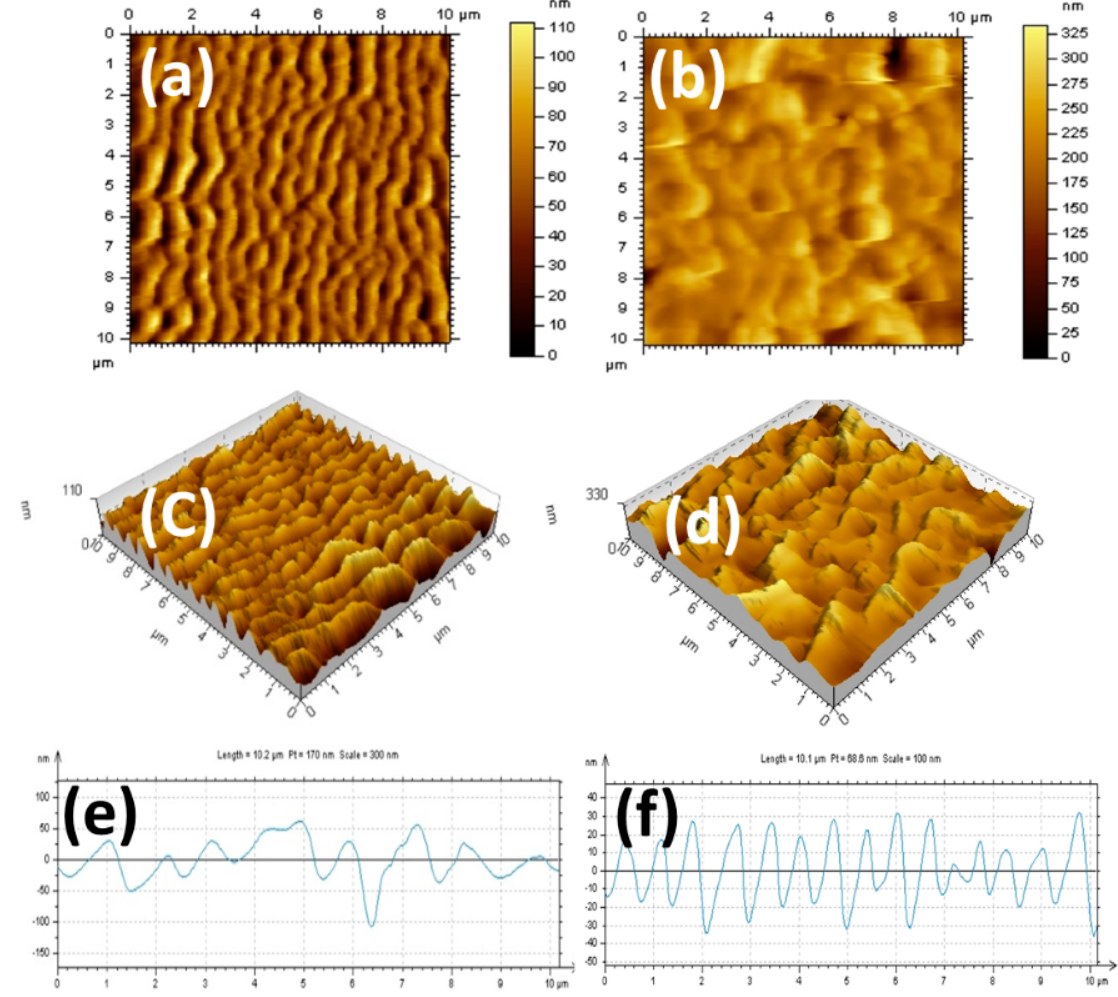
Figure 3. ( a ) Topography of pristine Nafion membrane; ( b ) Topography of Nafion-CeO 2 (1 wt. %) composite membrane; ( c ) Phase image of pristine Nafion membrane; ( d ) Phase image of Nafion-CeO 2 (1 wt. %) composite membrane; ( e ) Line profile of pristine Nafion membrane; ( f ) Line profile of Nafion-CeO 2 (1 wt. %) composite membrane.